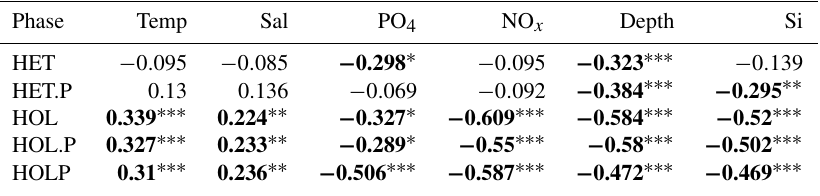
Table 6. Spearman correlations for the AMT data set.